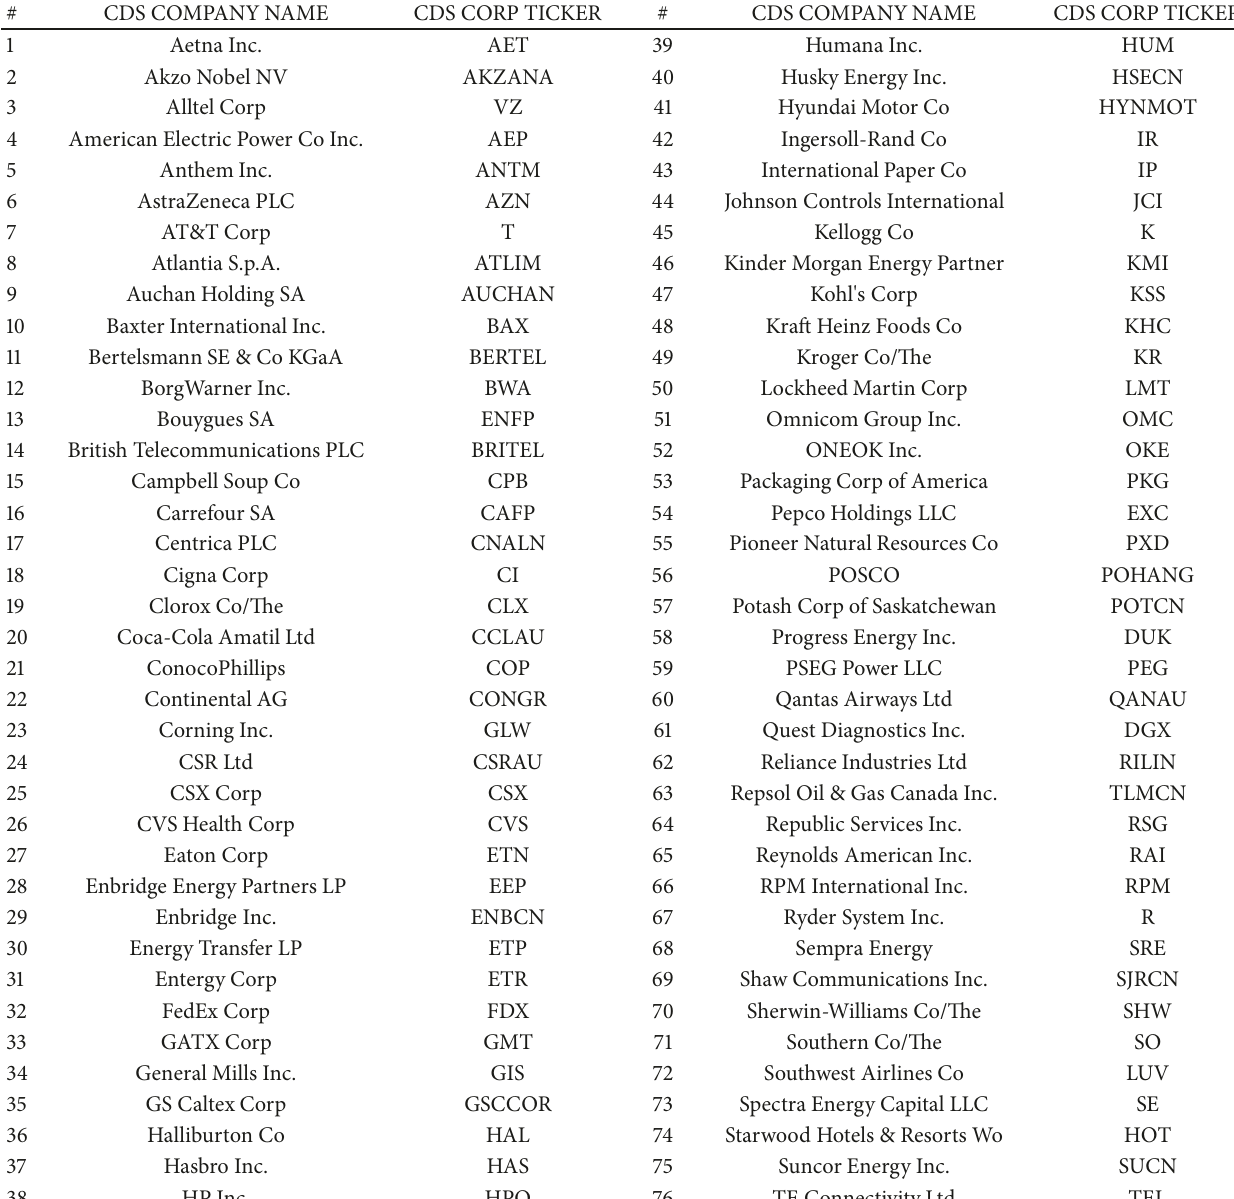
Table 5: Companies used for the IG BBB+